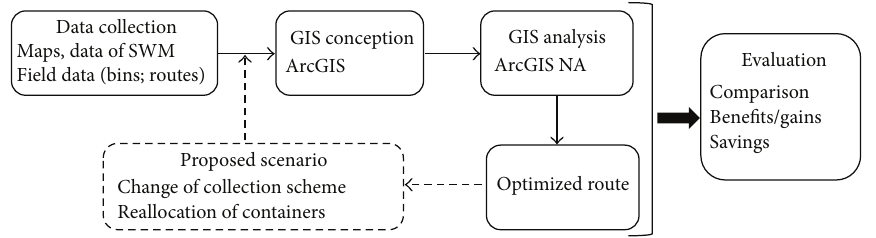
Figure 4: Methodology and analysis